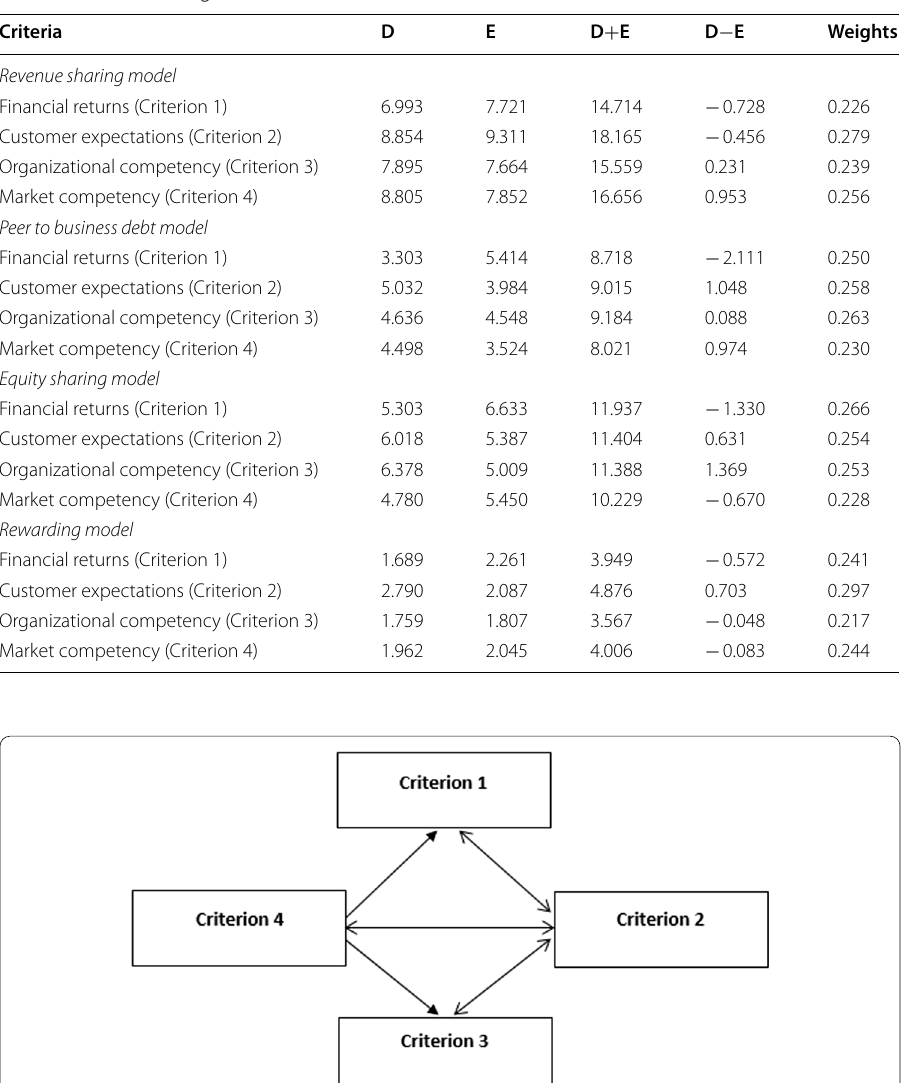
Table 22 Total cause, effect, and weights of multidimensional due diligence with consensus for